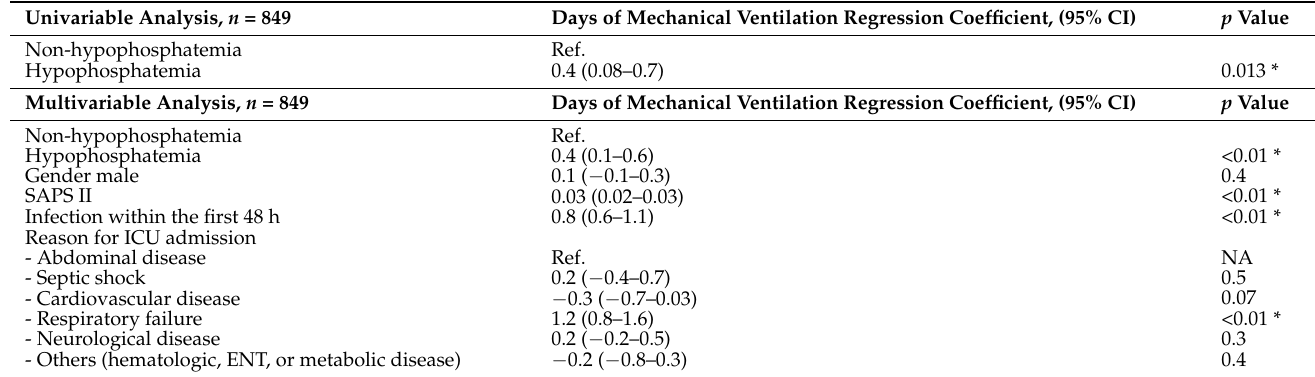
Table A2. Hypophosphatemia and time under mechanical ventilation.